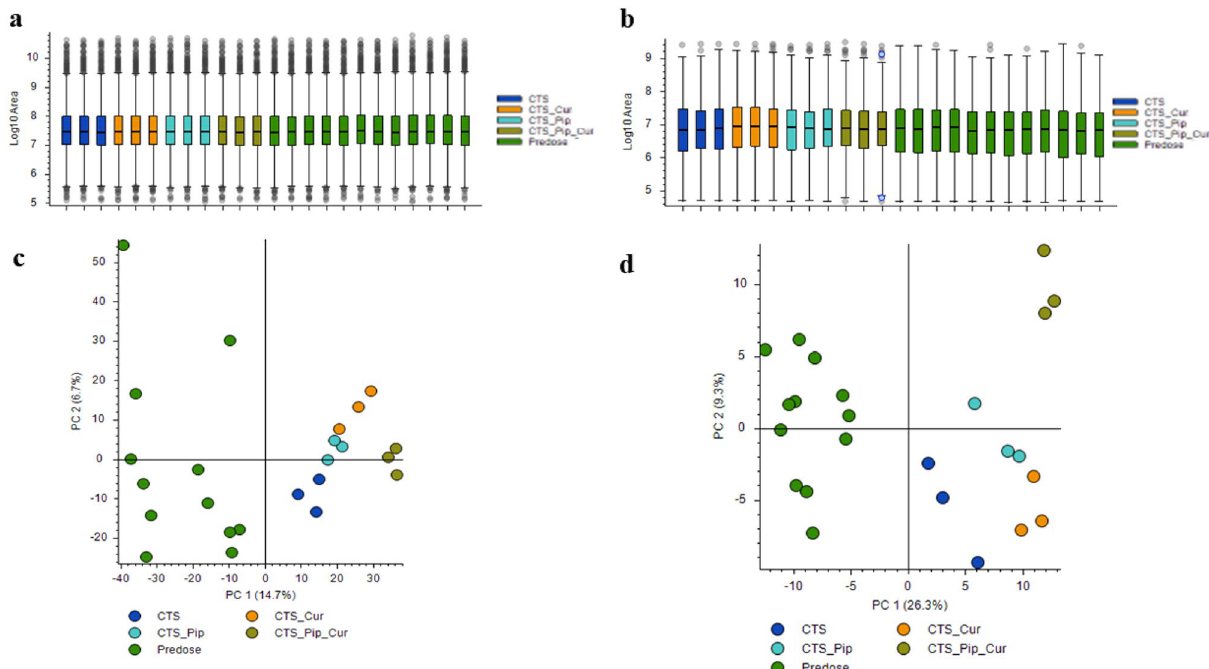
Figure 3. The distribution of mass area in each plasma sample group: Centella asiatica (CTS) extract alone, in combination with curcumin (CTS_Cur), in combination with piperine (CTS_Pip) and in combination with both curcumin and piperine (CTS_Pip_Cur) in ( a ) positive mode and ( b ) negative mode. The PCA plot of metabolites from ( c ) positive mode and ( d ) negative mode of each plasma sample